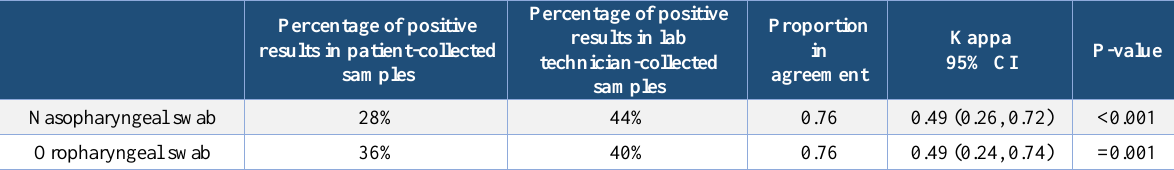
Table 3. Nasopharyngeal and oropharyngeal swabs collected for the diagnosis of COVID-19 using rRT-PCR by the lab technician and patients